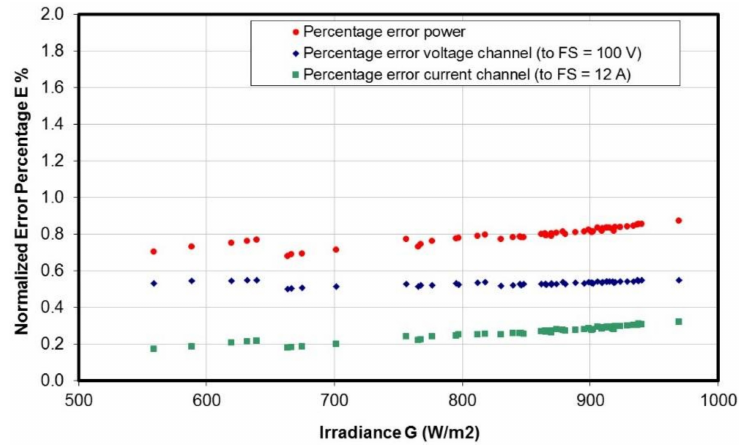
Figure 10. Variation of the percentage error of the power, the voltage channel and the current channel for the thin-film PV module.